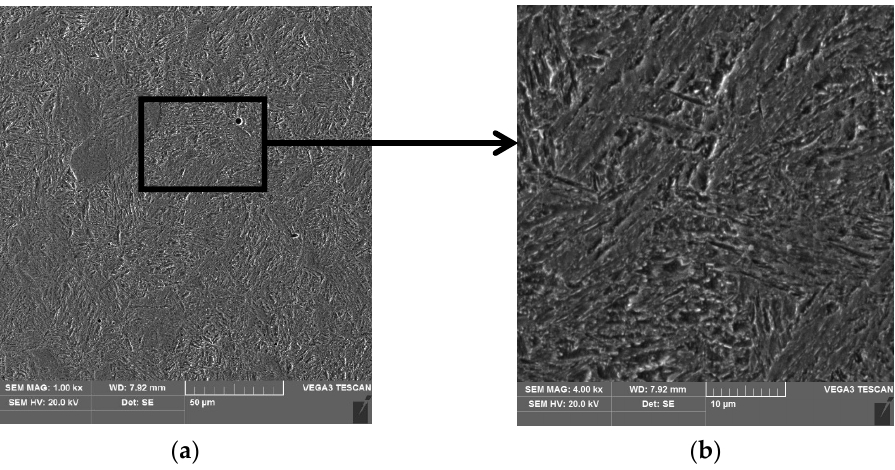
Figure 11. Microstructure of the new shaft journal (without hardfacing) ( a ), detail from ( a ) visible fine grains of highly tempered martensite ( b ).